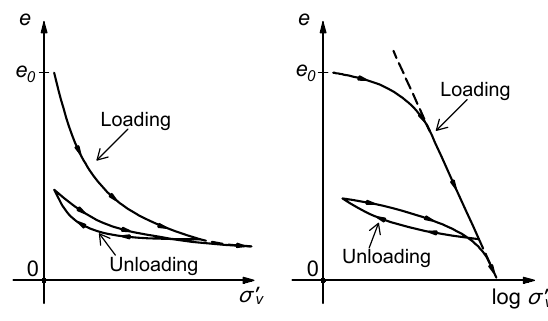
Figure 5. Typical e − log σ (cid:48) relationship.